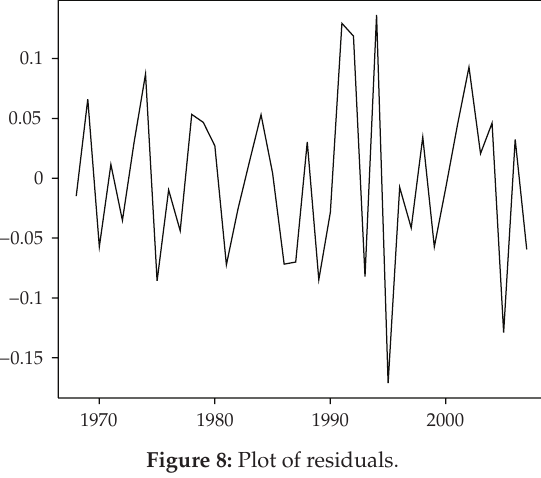
Figure 8: Plot of residuals.